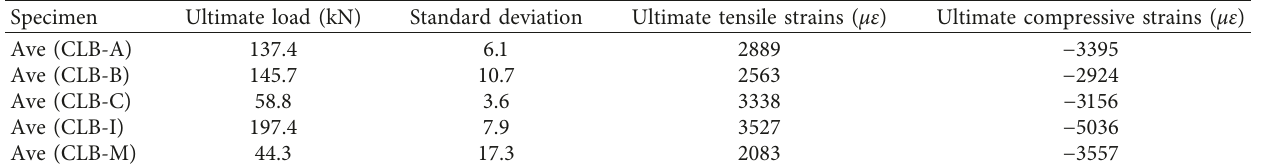
Figure 18: Load-midspan displacement curves of CLB slabs strengthened with CFRP grids. Table 5: Test results of all